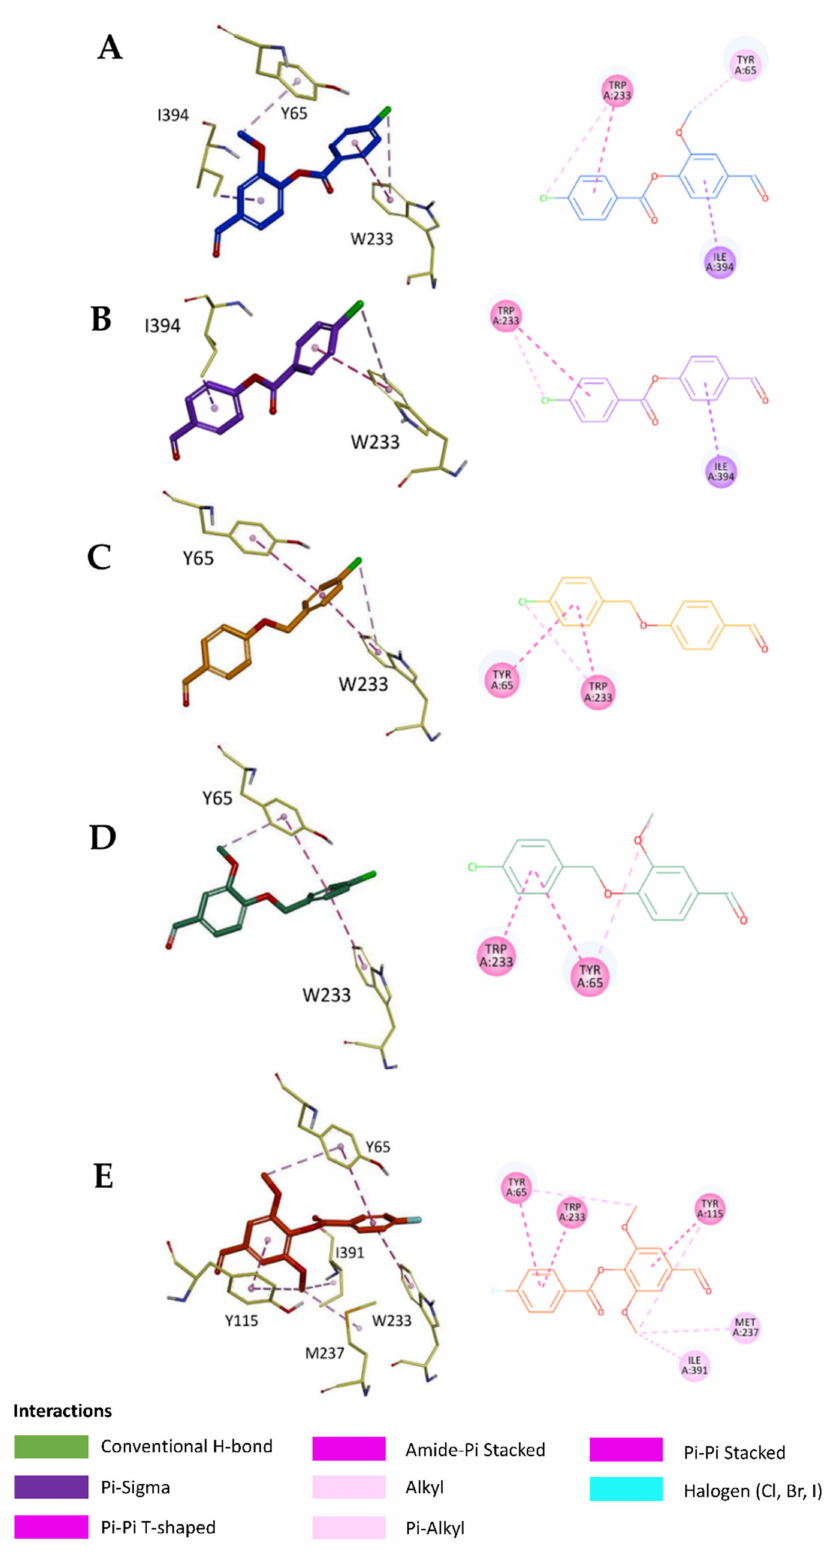
Figure 6. Molecular docking of: ( A ) ABMM-1 (blue), ( B ) ABMM-2 (purple), ( C ) ABMM-15 (orange), ( D ) ABMM-16 (green) and ( E ) ABMM-18 (red) into the ALDH3A1 binding site (yellow-colored